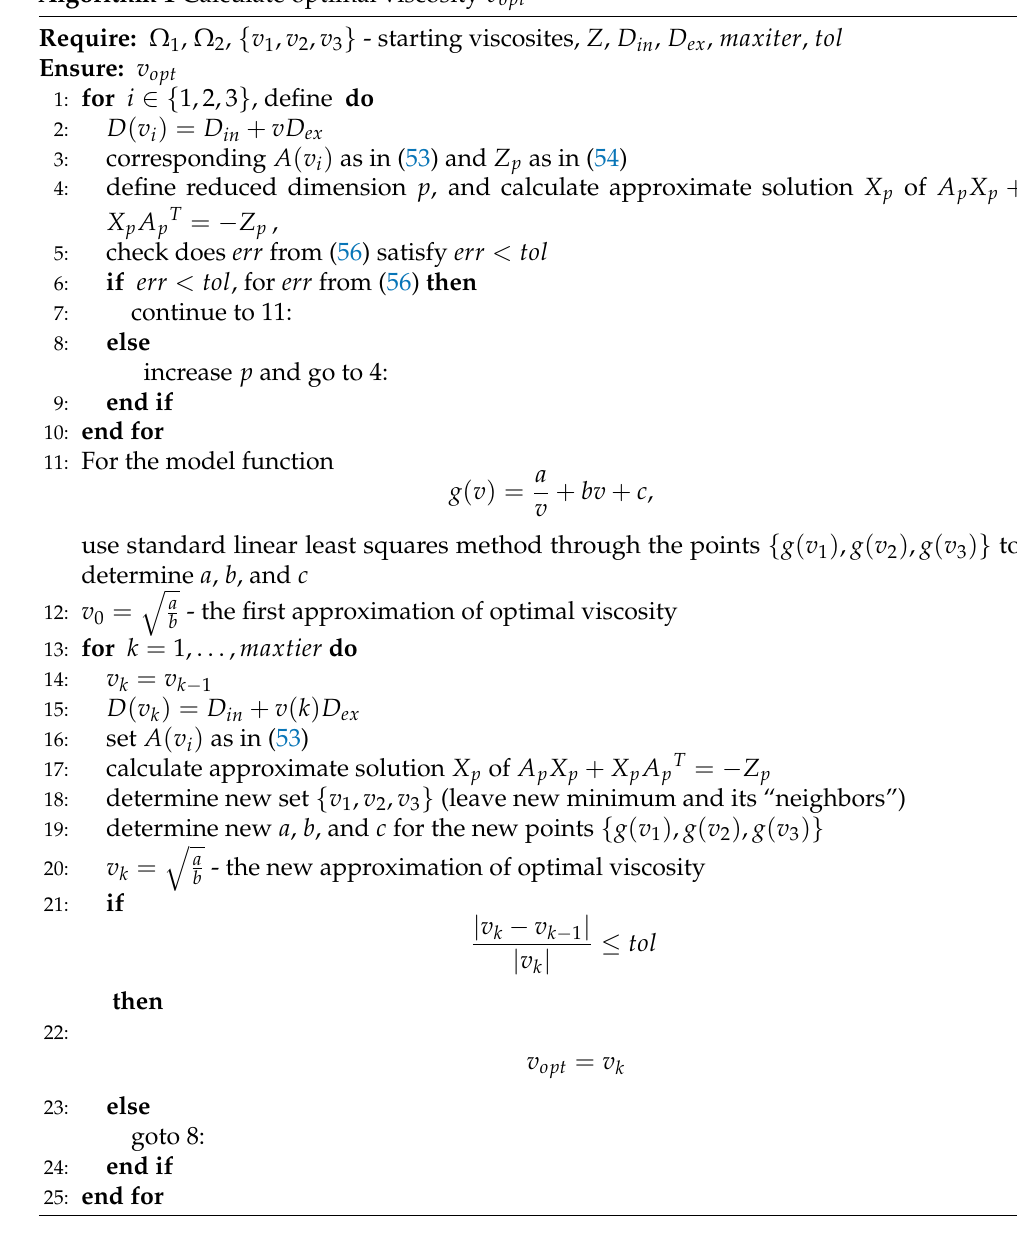
Algorithm 1 Calculate optimal viscosity v